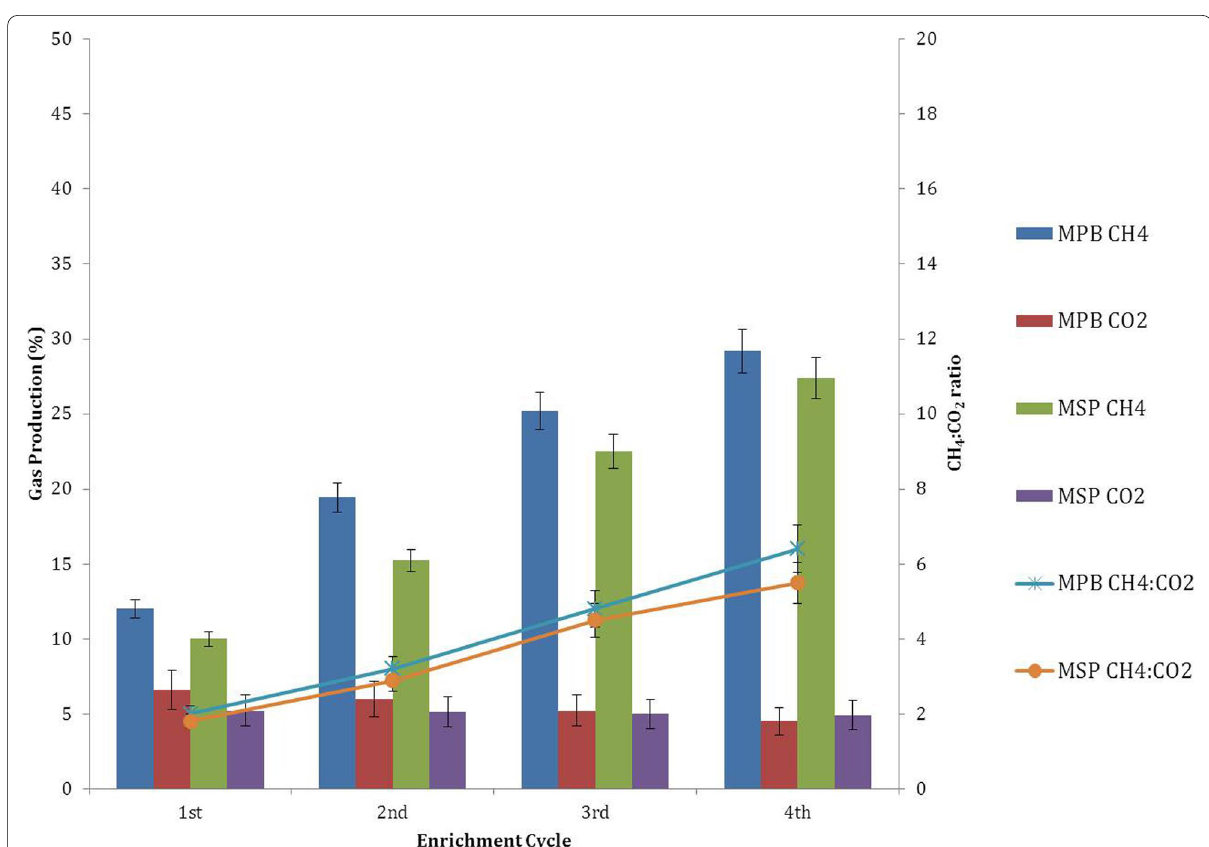
Fig. 3 Explained the percent of gas generation by developed consortia in MSP and MPB medium respectively where waste coal was used as carbon source in various enrichment cycles. Data recorded after 20 days of